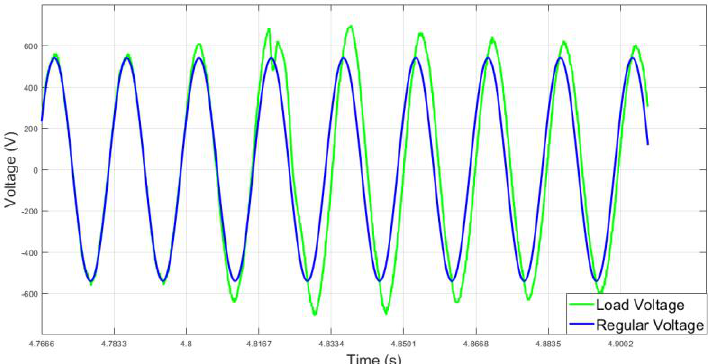
Figure 13. Stage 4: Backup on capacitive loads — load voltage of analysis.